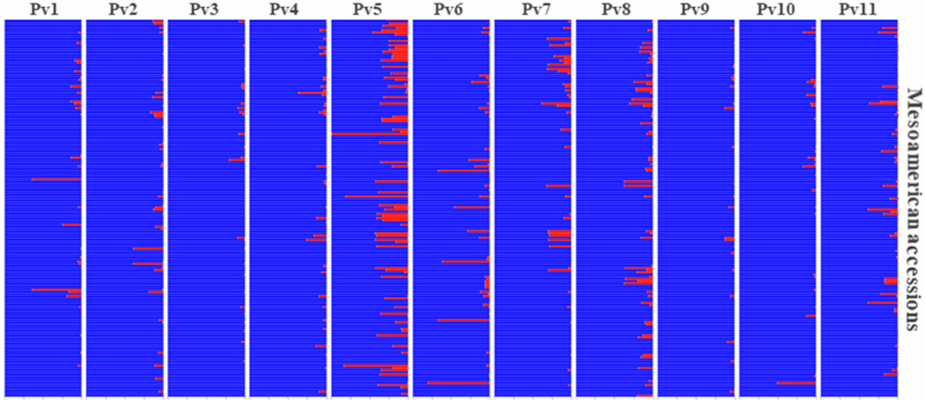
Figure 5. Structure analysis for each chromosome individually plotted for K = 2 to identify events of chromosome introgression of the Andean gene pool (red cluster) into the Mesoamerican accessions ( n = 175). Each plot represents one chromosome (as indicated), and the bars represent the Mesoamerican